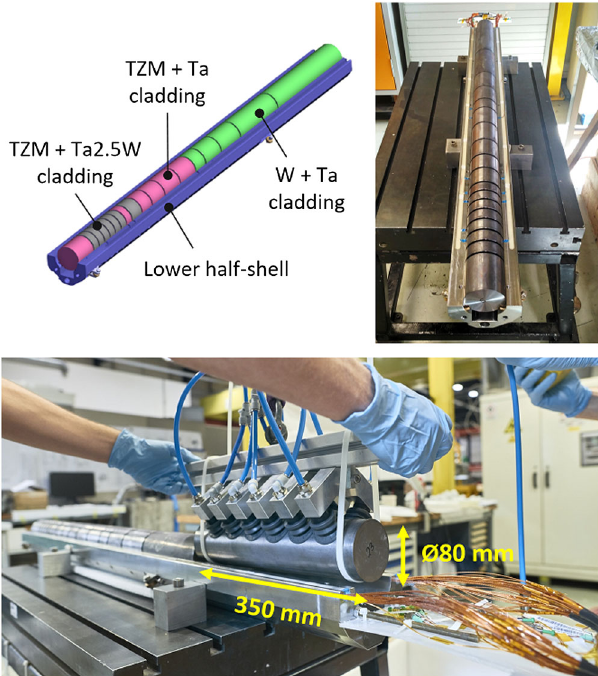
FIG. 4. BDF target prototype inner tank lower shell and target blocks description (top left). Full target core assembly laying on the inner tank lower shell (top right). Installation of the largest tungsten core block ( ∼ 33 kg) on the inner tank lower shell with help of a custom built suction cup (bottom) [20].